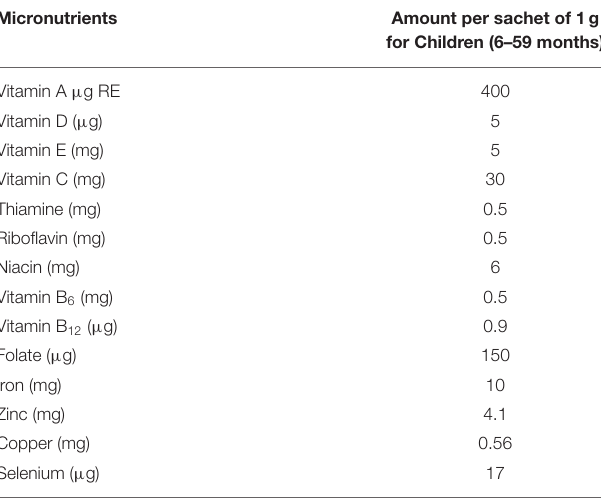
TABLE 2 | Formulation of the micronutrient powder (MNP) used in the supplementation program. Micronutrients